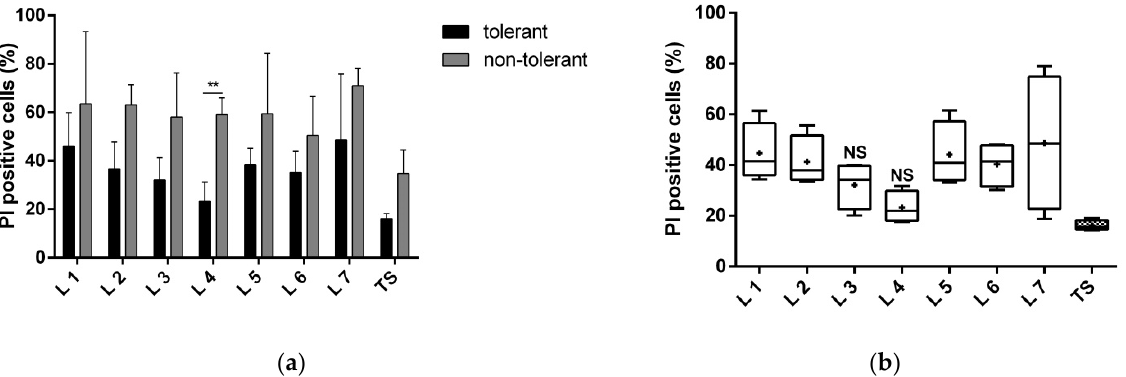
Figure 2. The number of dead cells exposed to 200 µM glutamate and co-cultivated with the total tolerant or non-tolerant secretomes and protein fractions of the total secretomes. Protein fractions (1–7) were separated with native polyacrylamide gel electrophoresis. The number of PI-positive cells is expressed as a percentage of the total number of cells. The tests were performed after 24 h of incubation in four replicates of three cultivations. ( a ) Comparison of the neuroprotective effect of the tolerant versus non-tolerant secretomes and their respective fractions. The data are presented as the mean ± standard deviation (** p < 0.01). ( b ) Comparison of the neuroprotective effects of the individual fractions of the tolerant secretome to the total secretome. The graph presents the minimum to the maximum values with the median bar; + indicates the mean. NS, nonsignificant changes in the dead cell count, compared with the total secretome; TS, total secretome.